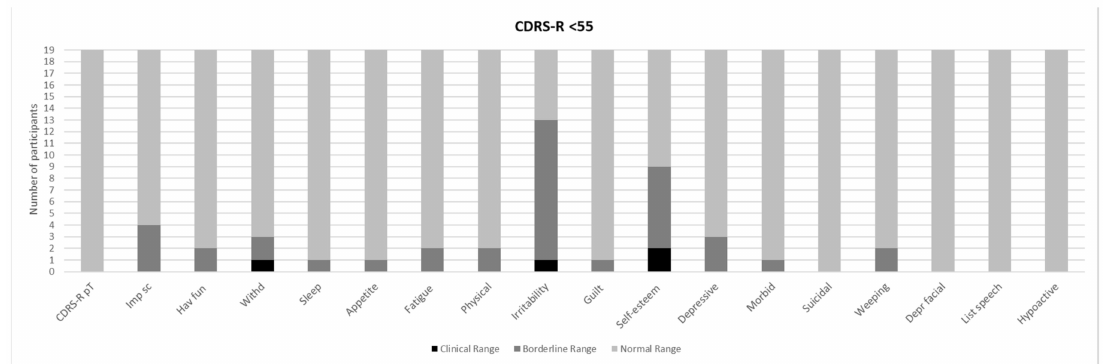
Figure 2. Prevalence of depressive symptoms in CDRS-R < 55 (CDRS-R-). Imp sc: Impaired schoolwork; Hav fun; Difficult